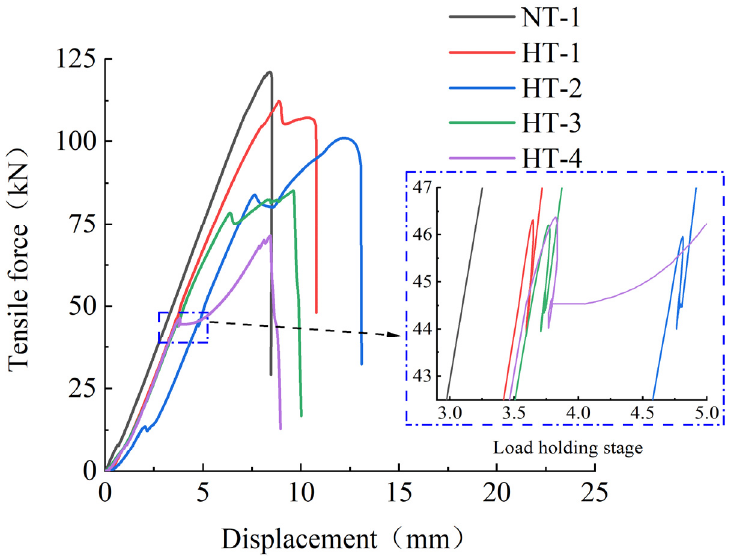
Figure 4. Tensile force–displacement of each test.